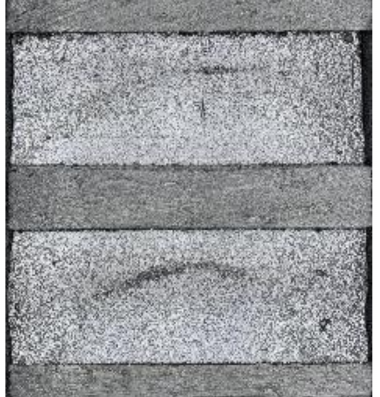
Figure 10. Surface quality W308B, magnification 10 ×